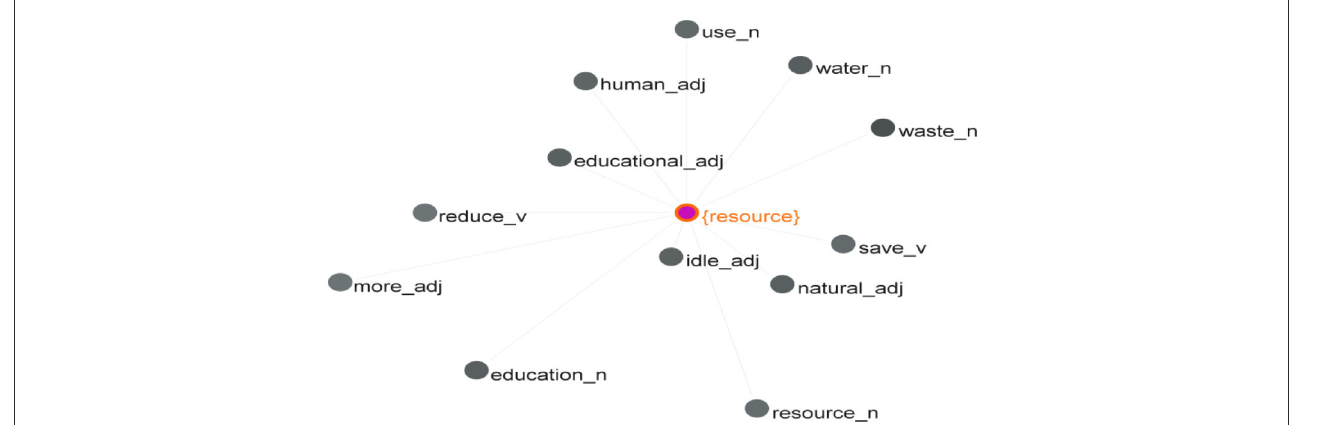
FIGURE1 Significant collocates of resource .